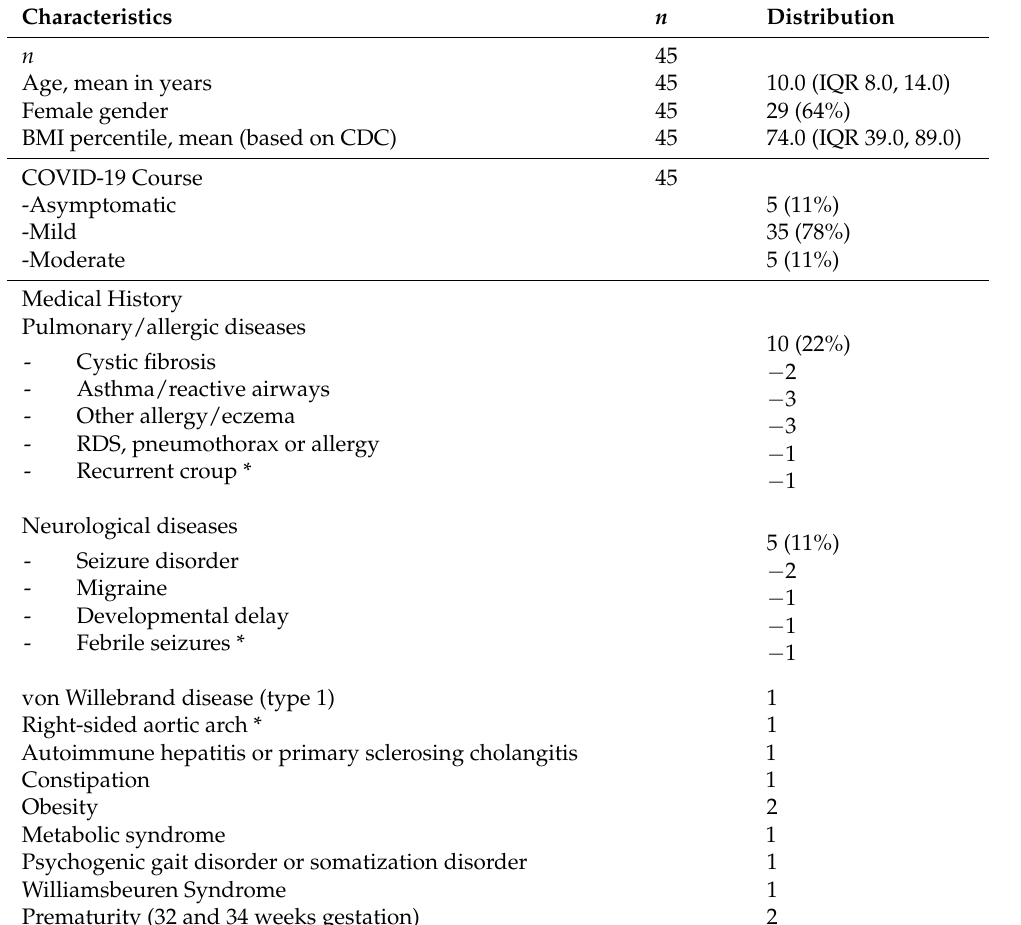
Table 1. Patient characteristics and medical